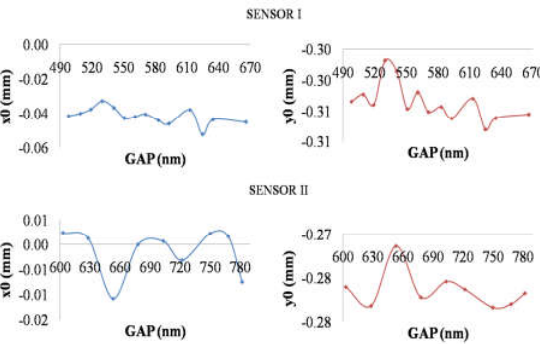
Figure 7: Estimated values for the coordinates of the principal point for both sensors.